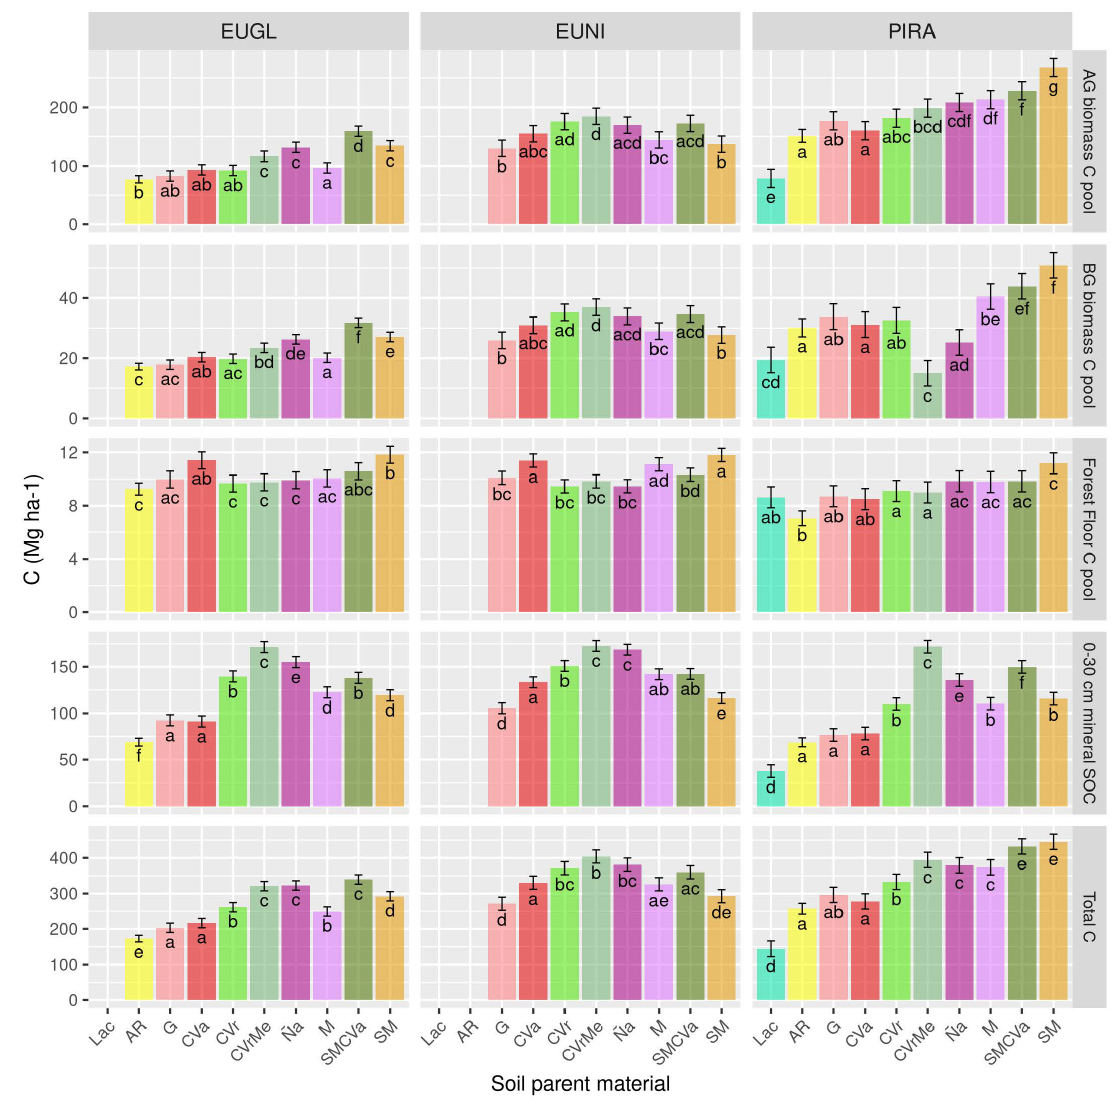
Figure 9. Mean and confidence interval of the mean for the 4 carbon pools (Above-ground (AG) biomass, Below-ground (BG) biomass, forest floor and 0–30 mineral soil organic carbon (SOC) C pools) and the total C for Eucalyptus globulus (EUGL), Eucalyptus nitens (EUNI) and Pinus radiata (PIRA) at the soil parent material evaluated: soils formed over lacustrine parent material (Lac), soils formed from sandy alluvial deposits (AR); soils formed from granitic materials (G); soils formed from old volcanic ashes deposits (CVa); soils formed from recent volcanic ashes deposits (CVr); soils formed from recent volcanic ashes deposits over metamorphic materials (CVrMe); Ñadis soils (Ña); soils formed over metamorphic parent material (M); soils formed over marine sediments covered by old volcanic ashes (SMCVa) and, soils formed over marine sediments (SM). Means denoted by a different letter indicate significant differences for p <